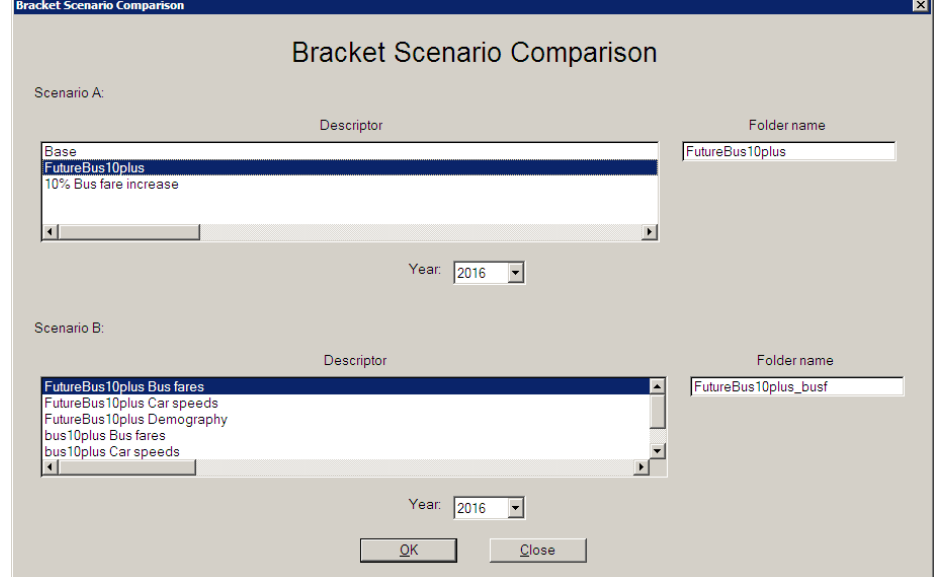
Figure 9. Scenario comparison window for bracket